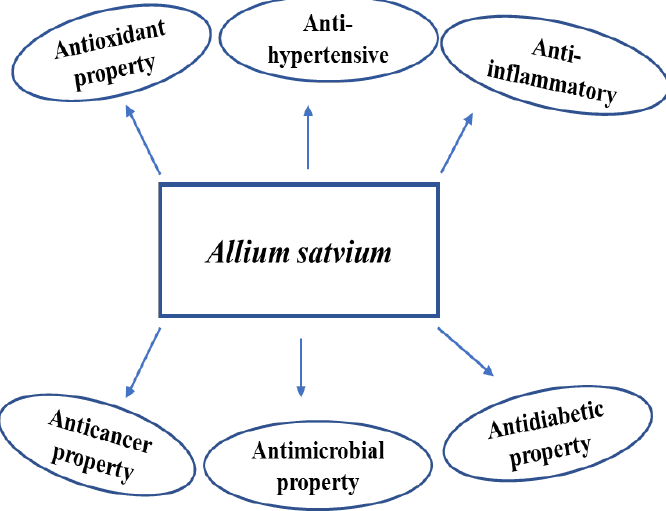
Figure 7. Pharmaceutical properties of garlic.